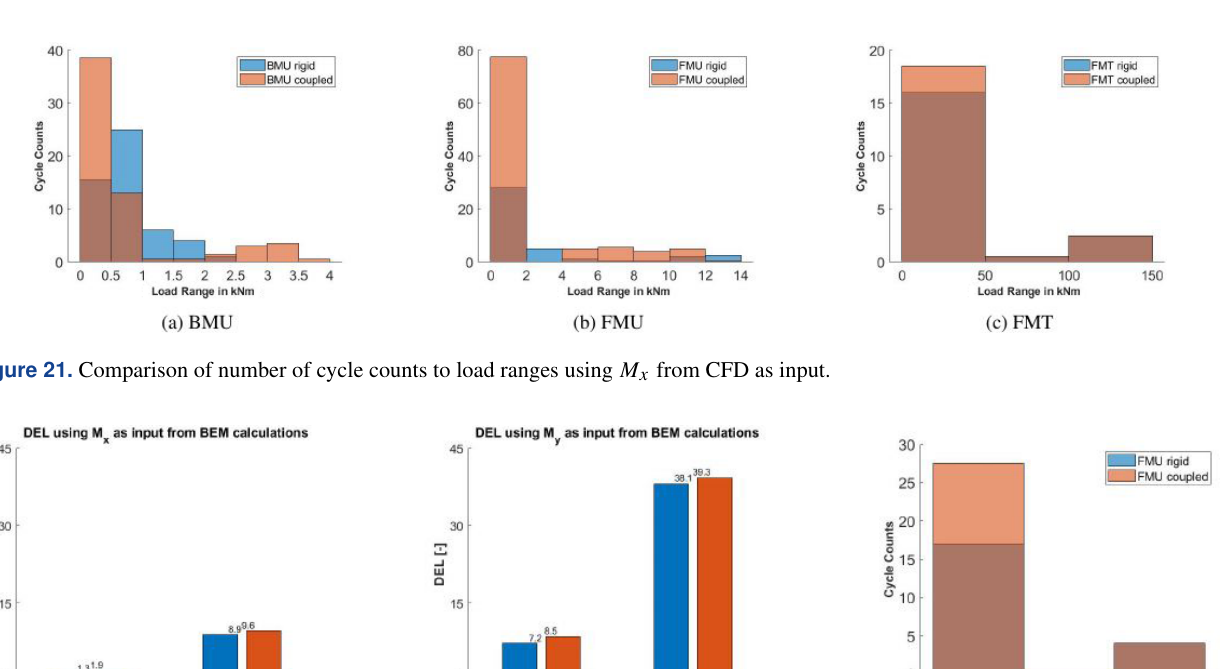
Figure 20. DEL calculation based on CFD for the different cases using in (a) M x and in (b) M y . Comparison between rigid (R) and coupled (C).